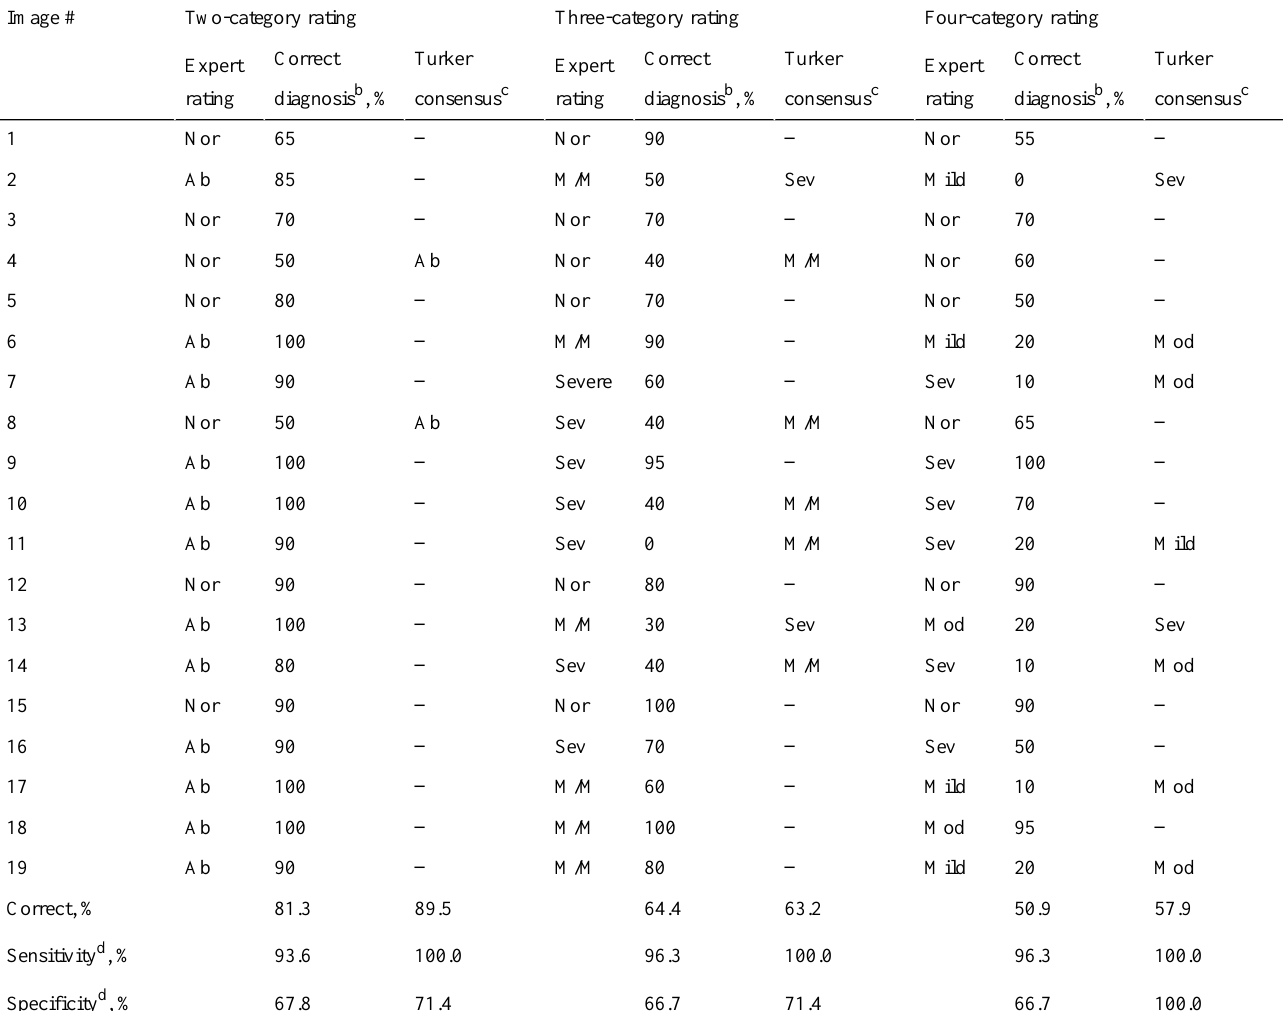
Table 1. Turker grading of individual images a .